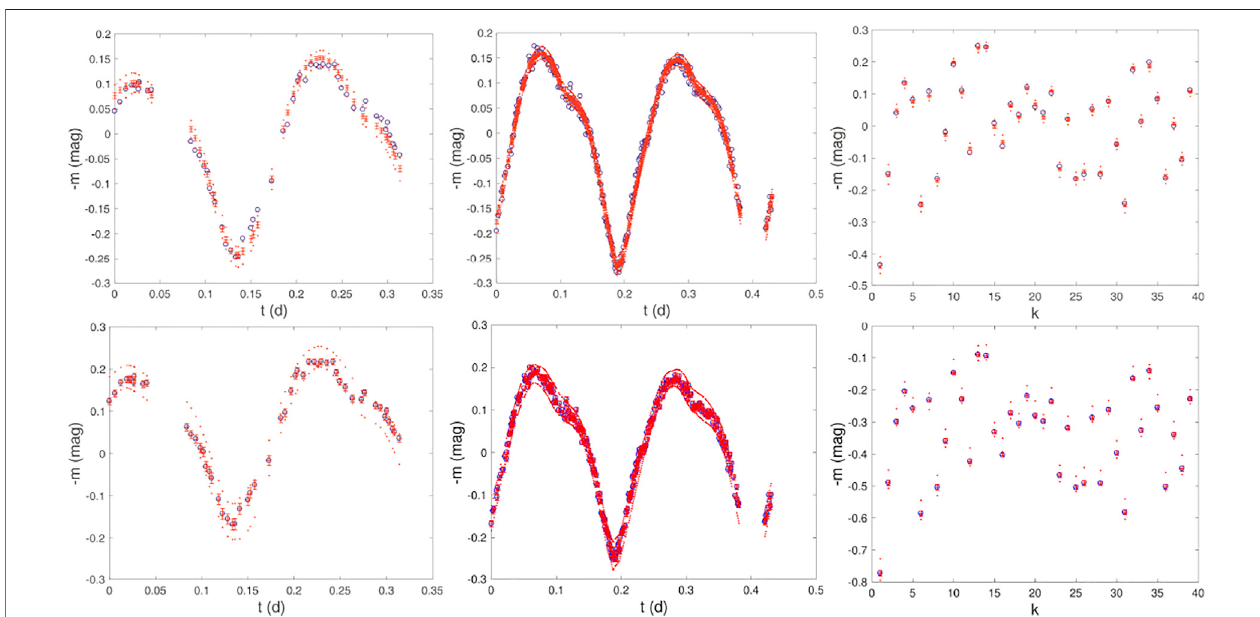
FIGURE 9 | Example photometric lightcurves for the Gaussian-random-sphere asteroid (GS-asteroid). We show the dense photometric lightcurves #12 and #5 and the sparse lightcurve (blue circles; left, middle, and right, respectively; see Tables 5 – 7 ) together with the best- fi t convex model lightcurves (red crosses) with 1- σ standard deviations (red bars) and uncertainty envelopes using all 30,000 Markov-chain Monte Carlo (MCMC) sample solutions (red points). We depict the results for relative (top) and absolute lightcurves (bottom). m , t , and k stand for relative magnitude, time from the fi rst lightcurve observation, and lightcurve observation counter,